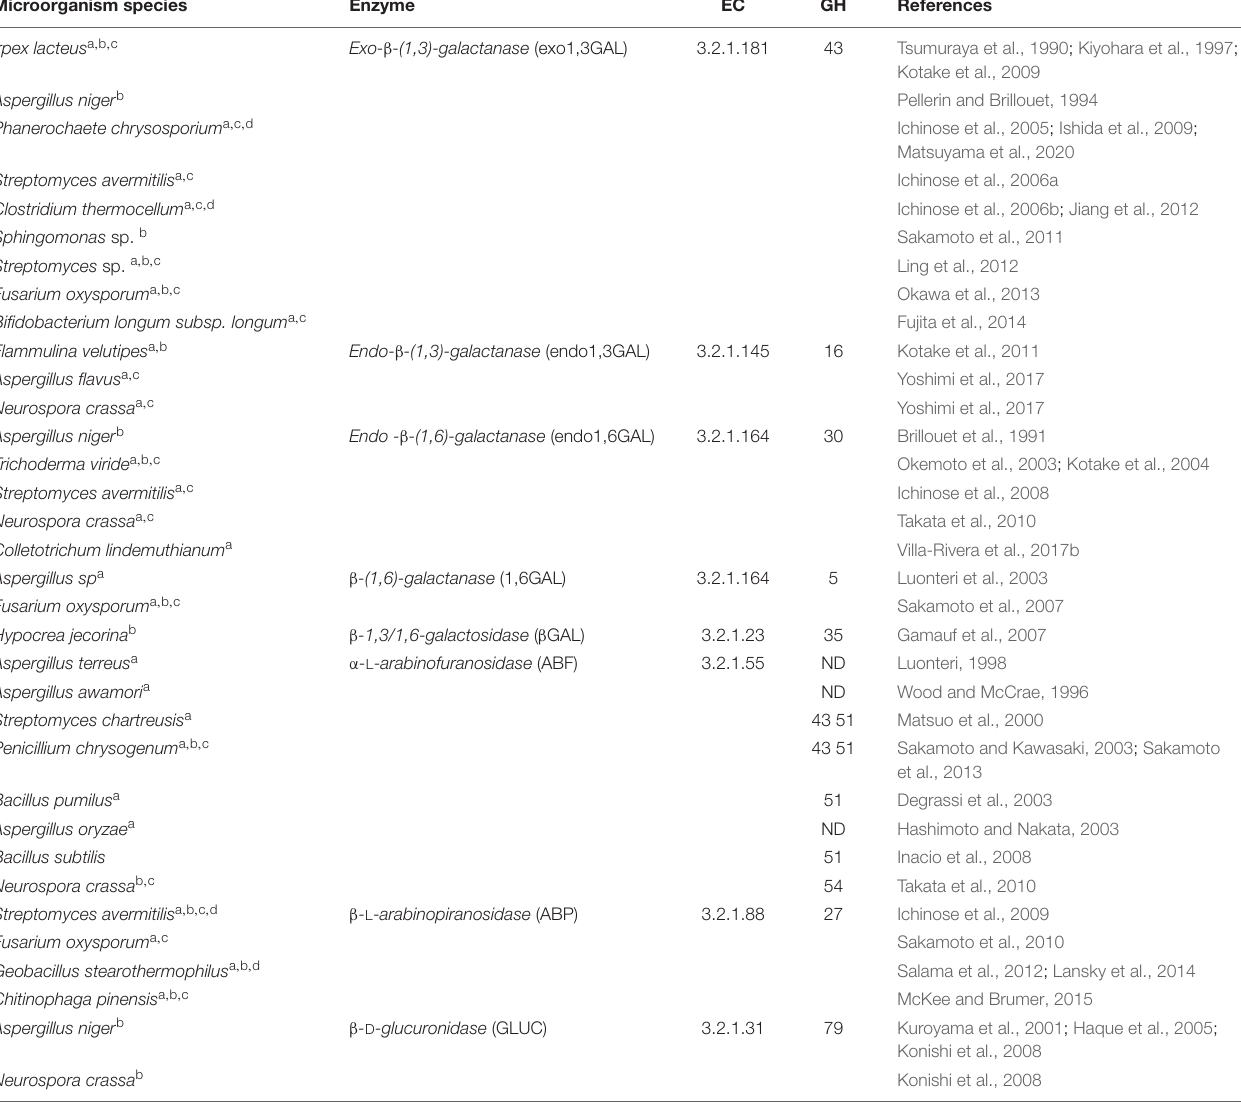
a Gene characterization. b Native protein characterization. c Recombinant protein characterization. d Crystallized structure. ND, Not